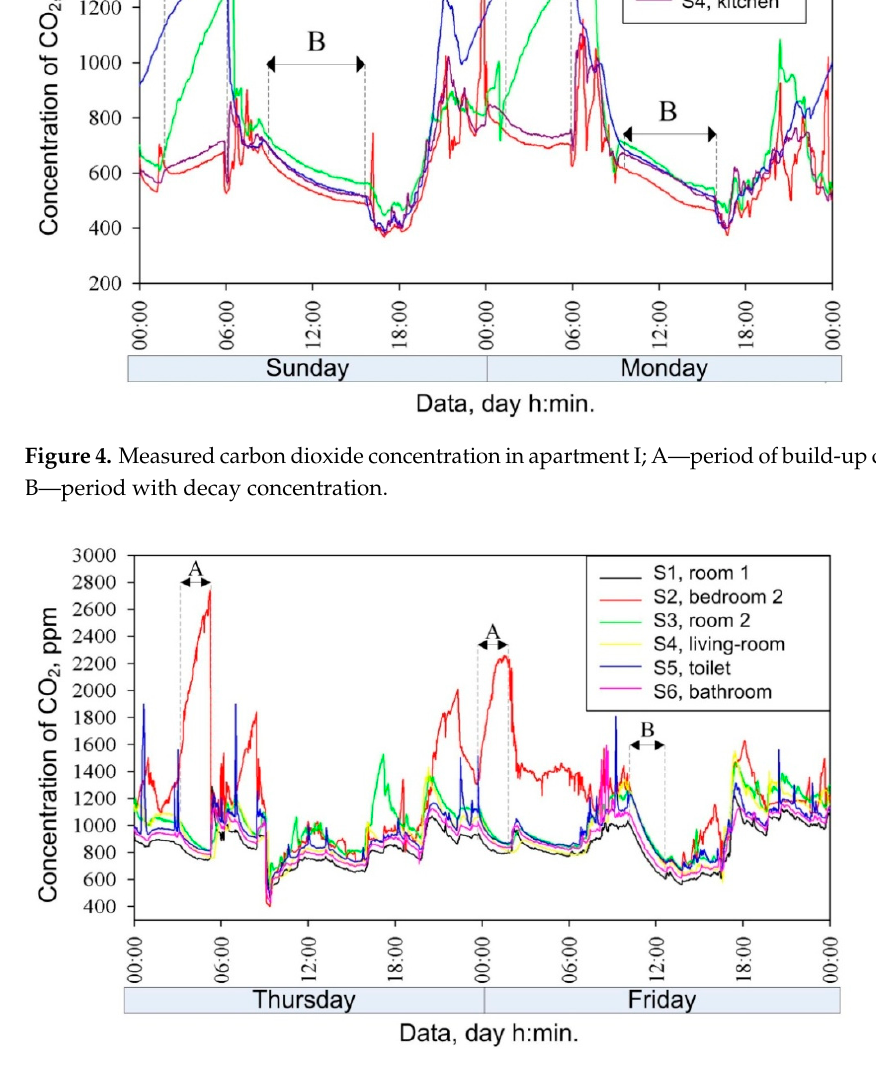
Figure 5. Measured carbon dioxide concentration in apartment II.